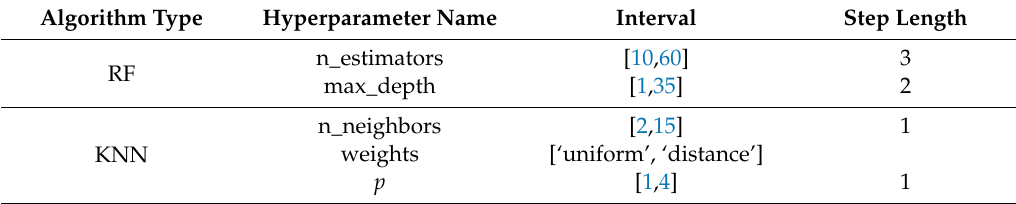
Table 4. Configuration for hyperparameters both in RF and KNN